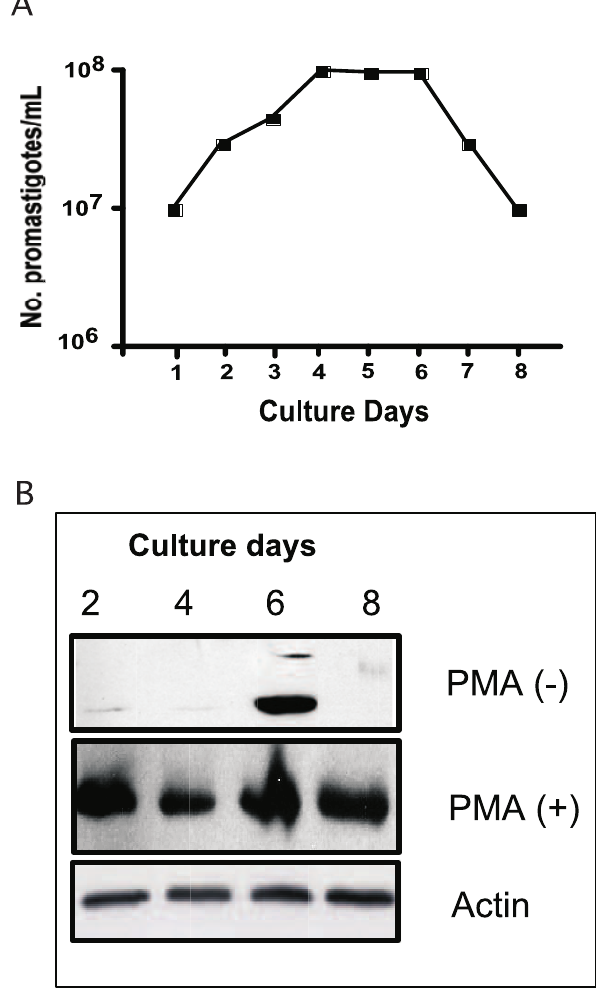
Figure 2. Leishmania PKC-like expression during proliferation. (A): Time proliferation curve of promastigotes. Parasites were cultured at 26 u C in Schneider’s insect medium supplemented with 10% of fetal bovine serum and antibiotics. Promastigotes were harvested at the 2 nd , 4 th , 6 th , and 8 th growth days and counted on a microscope. (B): Immunoblot analysis of L. mexicana promastigotes at different stages